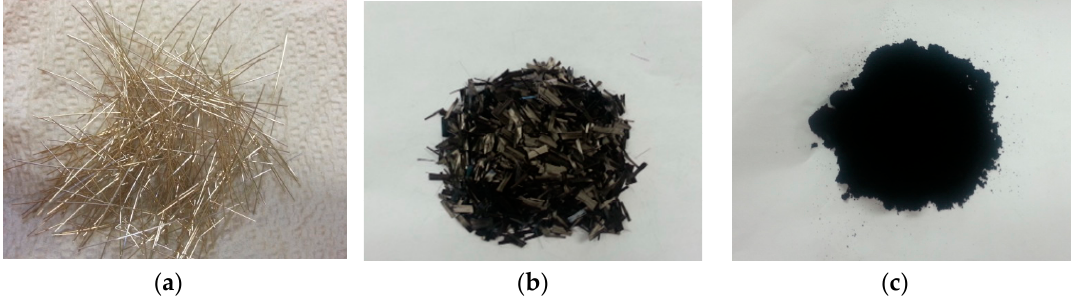
Figure 2. Conductive additives affixed into mortar matrix: ( a ) steel smooth fiber; ( b ) carbon fiber; ( c ) MWCNTs powder. ( c ) MWCNTs